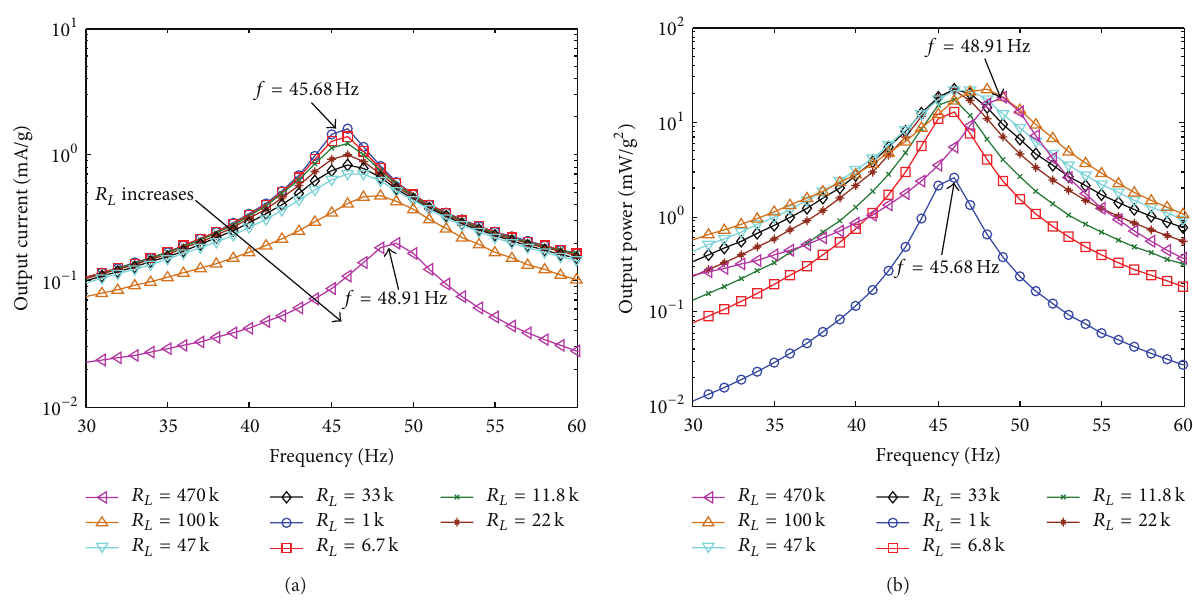
Figure 9: Output current (a) and output power (b) of the PVEH for various values of load